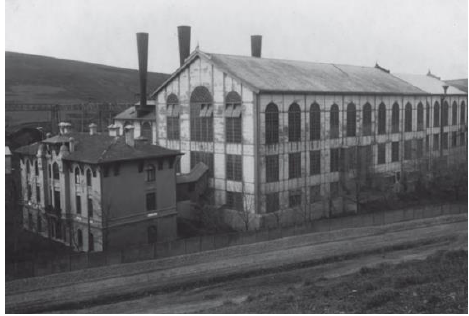
Figure 9. Silahtarağa Power Plant, view of the first machine room and administrative headquarters